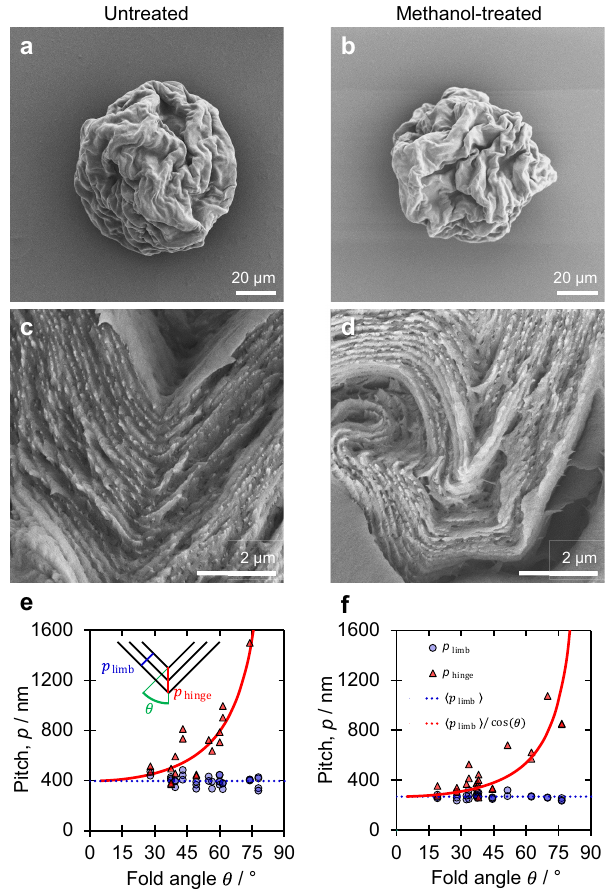
Fig. 4 The role of interfacial buckling on the pitch of the radially aligned CNC microparticles. Scanning electron microscopy (SEM) images of a representative microparticle ( a ) prior to and ( b ) after treatment with methanol, showing the volume contraction and increase in buckling. Corresponding cross-sectional images in ( c ) and ( d ) show the related decrease in the pitch of the helicoidal structure. e , f Limb and hinge pitches of ( e ) hexane-washed and ( f ) methanol-treated microparticles plotted as a function of the fold angle θ , as de fi ned in the inset schematic. For both samples, the limb pitch is independent of θ , while the hinge pitch generally follows the stated trigonometric